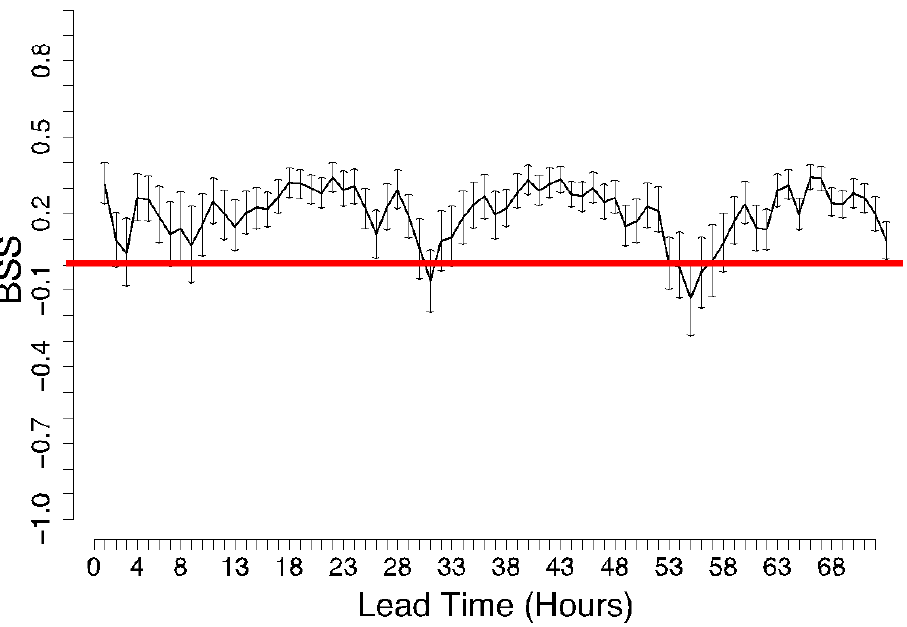
Figure 7. Brier skill score (BSS) of the analog ensemble (AnEn) with DICast as a reference, as a function of forecast lead time, computed over all the stations. The BSS 5%–95% bootstrap confidence intervals are also shown. The event considered is wind speed greater than 10 ms −1 .